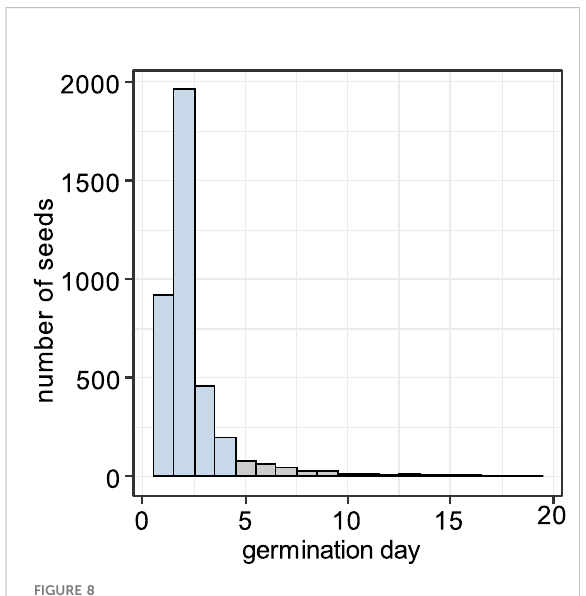
FIGURE 8 Histogram of germination timing. Seeds that germinated within the fi rst 4 days (blue) were treated as “ early ” and those that germinated later than 4 days (gray) as “ late ”